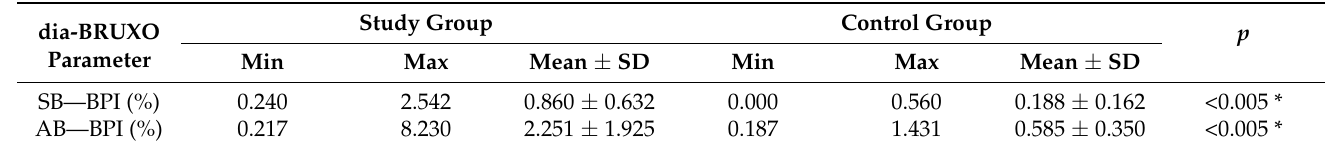
Table 5. BPI index in SB and AB.